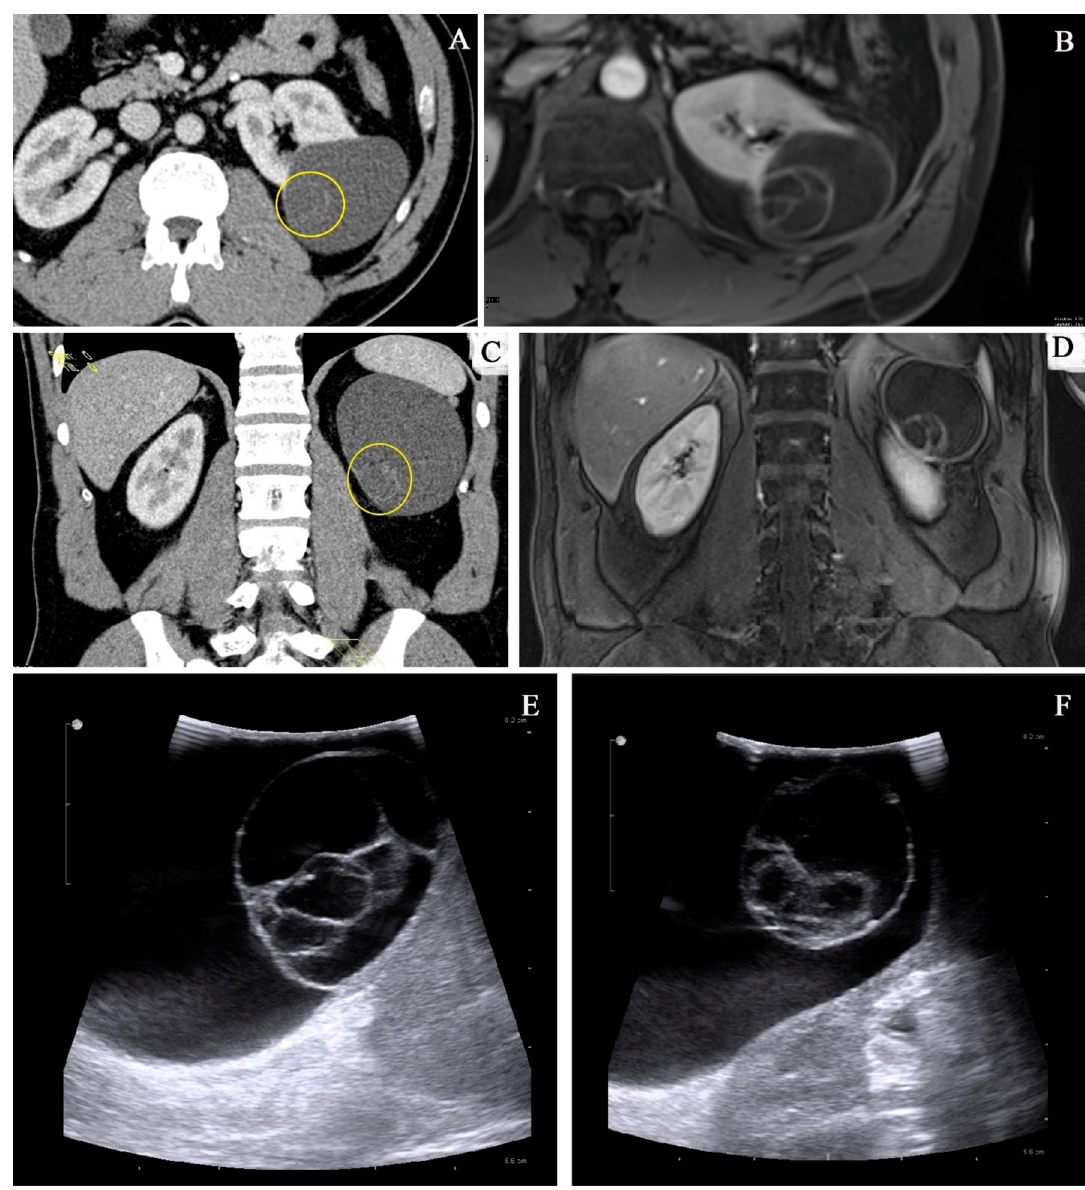
Figure 1. Imaging methods: comparison of CT imaging ( A , C ) and MRI ( B , D ) of the same lesion.